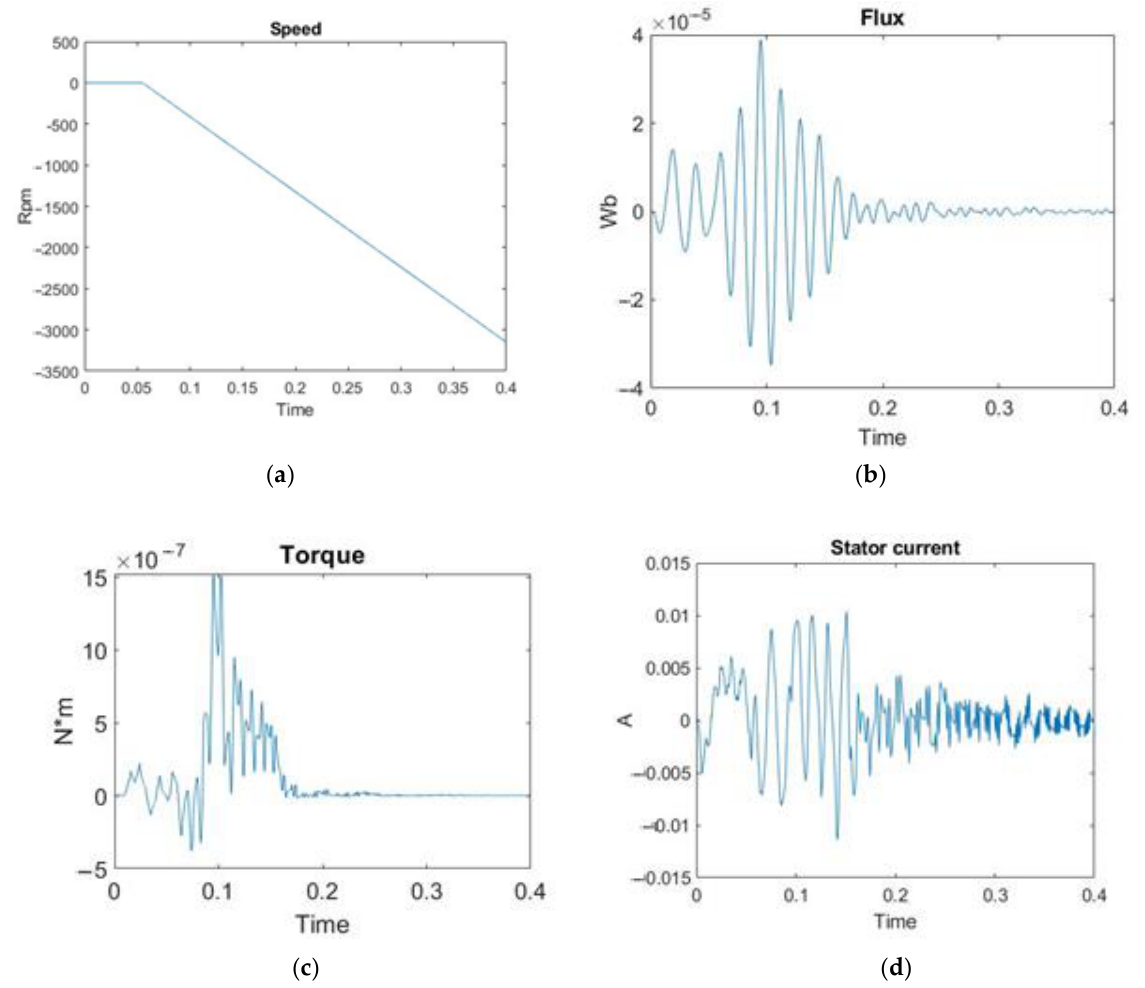
Figure 9. Output characteristics at a voltage less than nominal by 20%: ( a ) speed; ( b ) flux; ( c ) torque and ( d ) current.